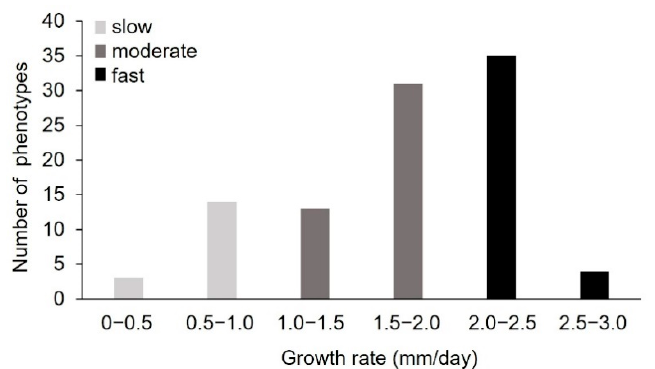
Figure 2. Distribution of vegetative growth rate of the P. sapidus monokaryons grown on standard nutrient liquid (SNL) agar plates. The strains were categorized as slow-, moderate-, and fast-growing strains according to the growth rate.